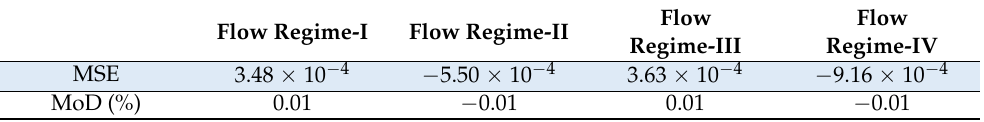
Figure 11. Numerical and ANN outputs for thermal Flow Regimes-I ( a ), -II ( b ), -III ( c ) and -IV ( d ). Table 5. Performance parameter results for each flow regime. Performance parameters were calculated and evaluated for the MLP neural network Flow Regime-I